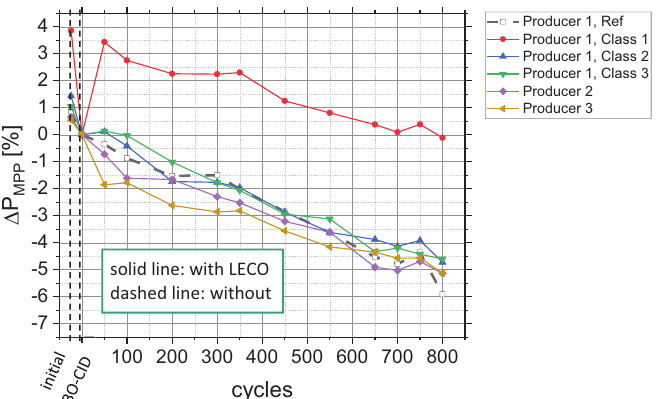
Fig. 4. Degradation of STC power of LECO modules in extended thermal cycling test; please note: the values before 0 are the initial measured data and at 0 are after